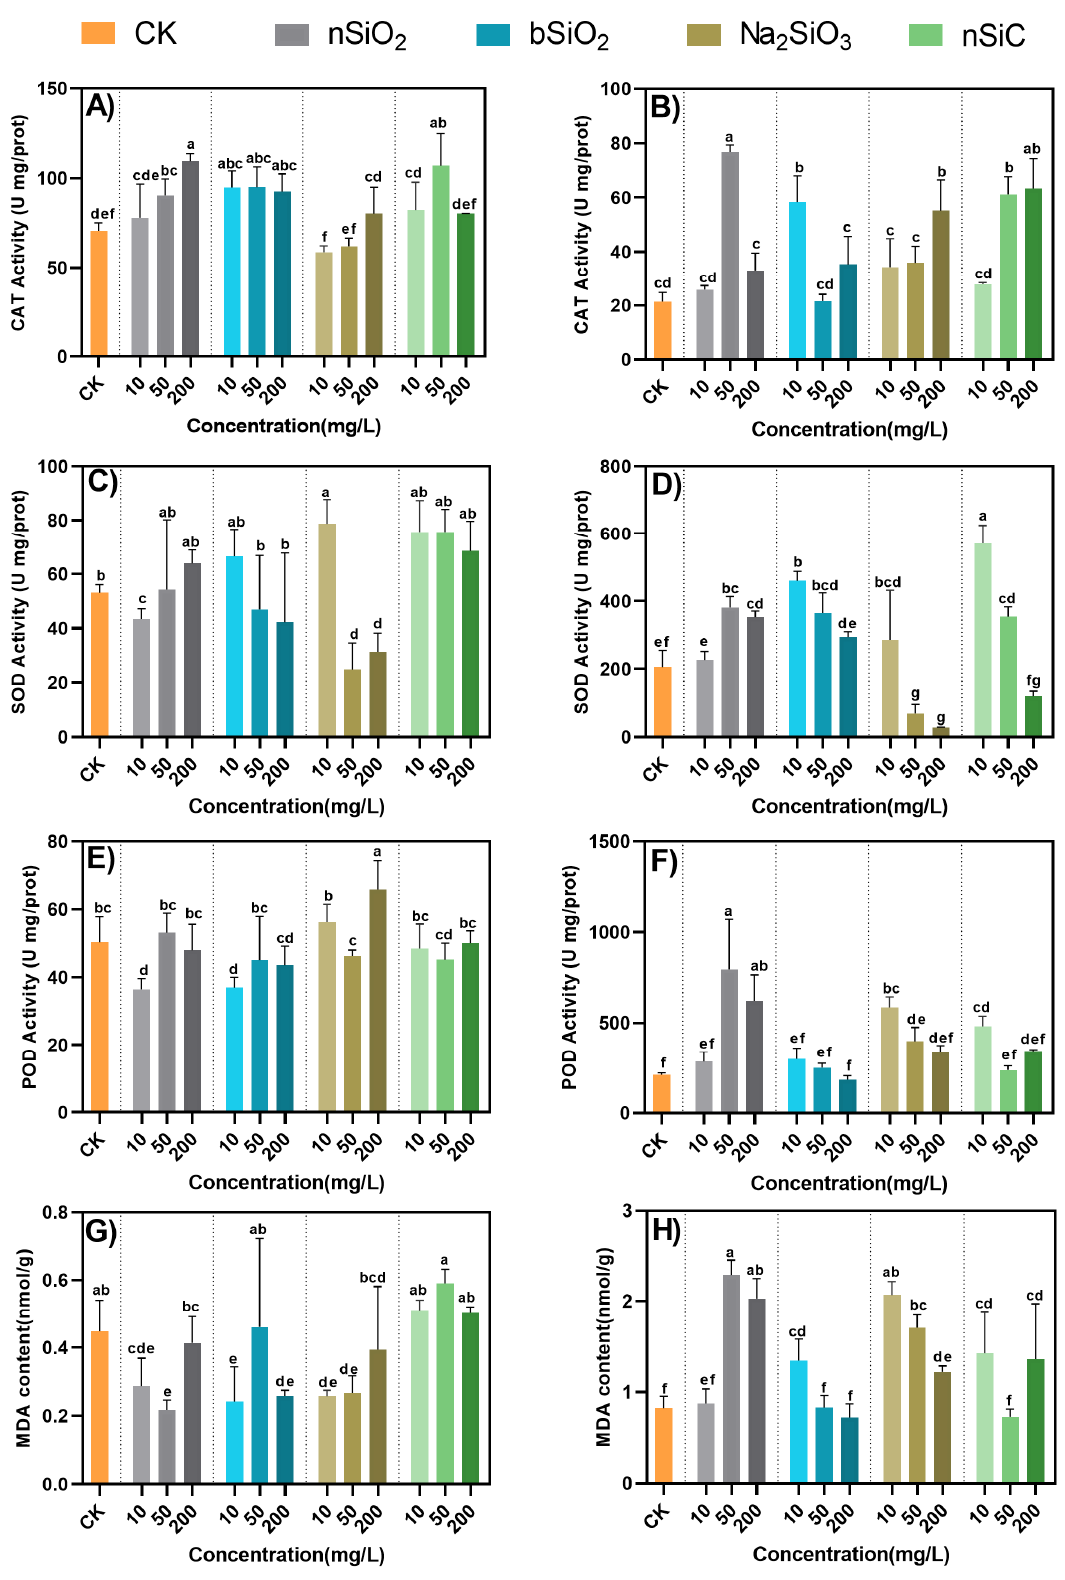
Figure 4. Effects of Si-based NMs on the antioxidant system of rice. CAT, SOD, POD activities and MDA content ( A , C , E , G ) of leaves; ( B , D , F , H ) of roots. Columns marked with the same letter were not significantly different at p < 0.05 ( n = 4).